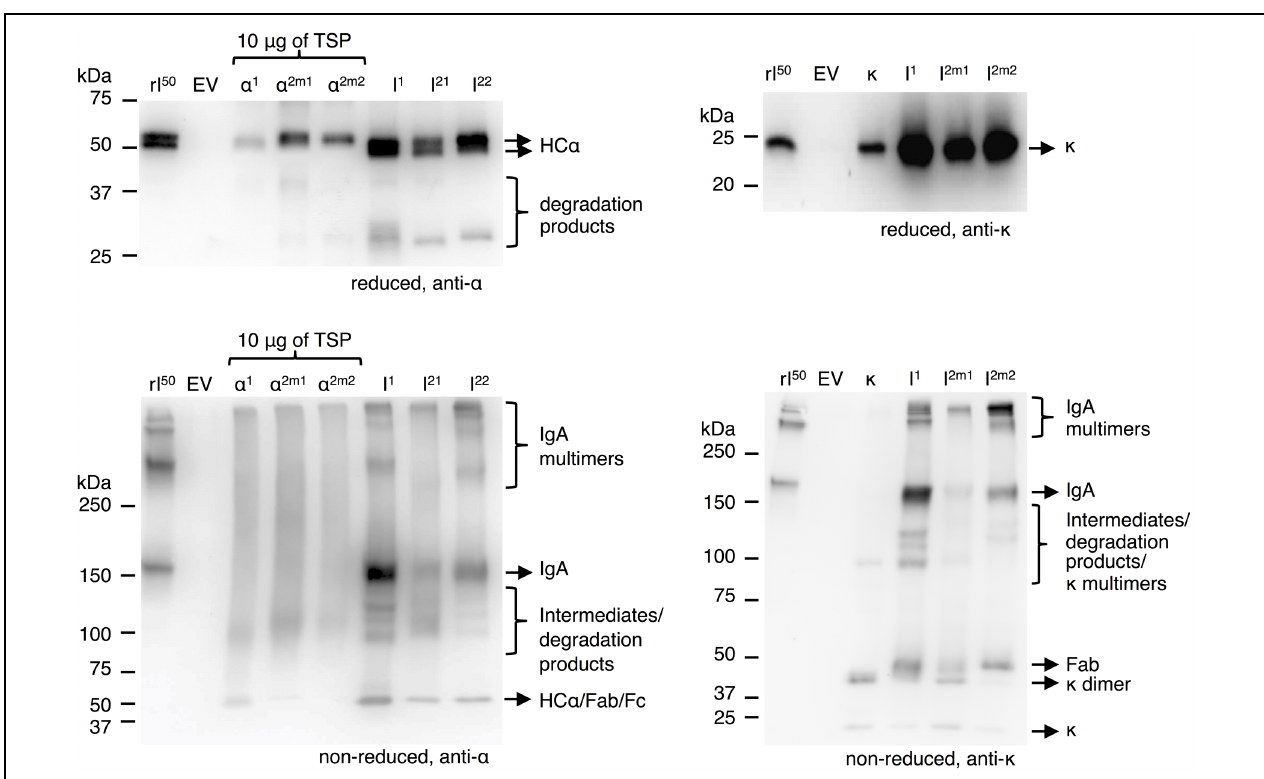
FIGURE 4 | IgA assembly using multi-cassette expression vectors. Leaves were agro-infiltrated for the expression of alpha heavy chain 1 ( α 1 ), 2m1 ( α 2m1 ), 2m2 ( α 2m2 ), and kappa chain ( κ ) individually or co-expressed (I) using a multi-cassette vector and harvested 6 dpi. TSPs were extracted and 1 μ g, unless stated otherwise, was separated by SDS-PAGE under reducing conditions followed by visualization using protein specific antibodies as indicated. As controls 50 ng of recombinant IgA1 κ (rI 50 ) and an EV sample were